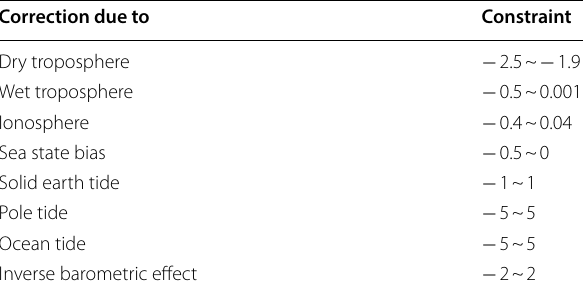
Table 1 Constraints on geophysical corrections (unit: m) Correction due to